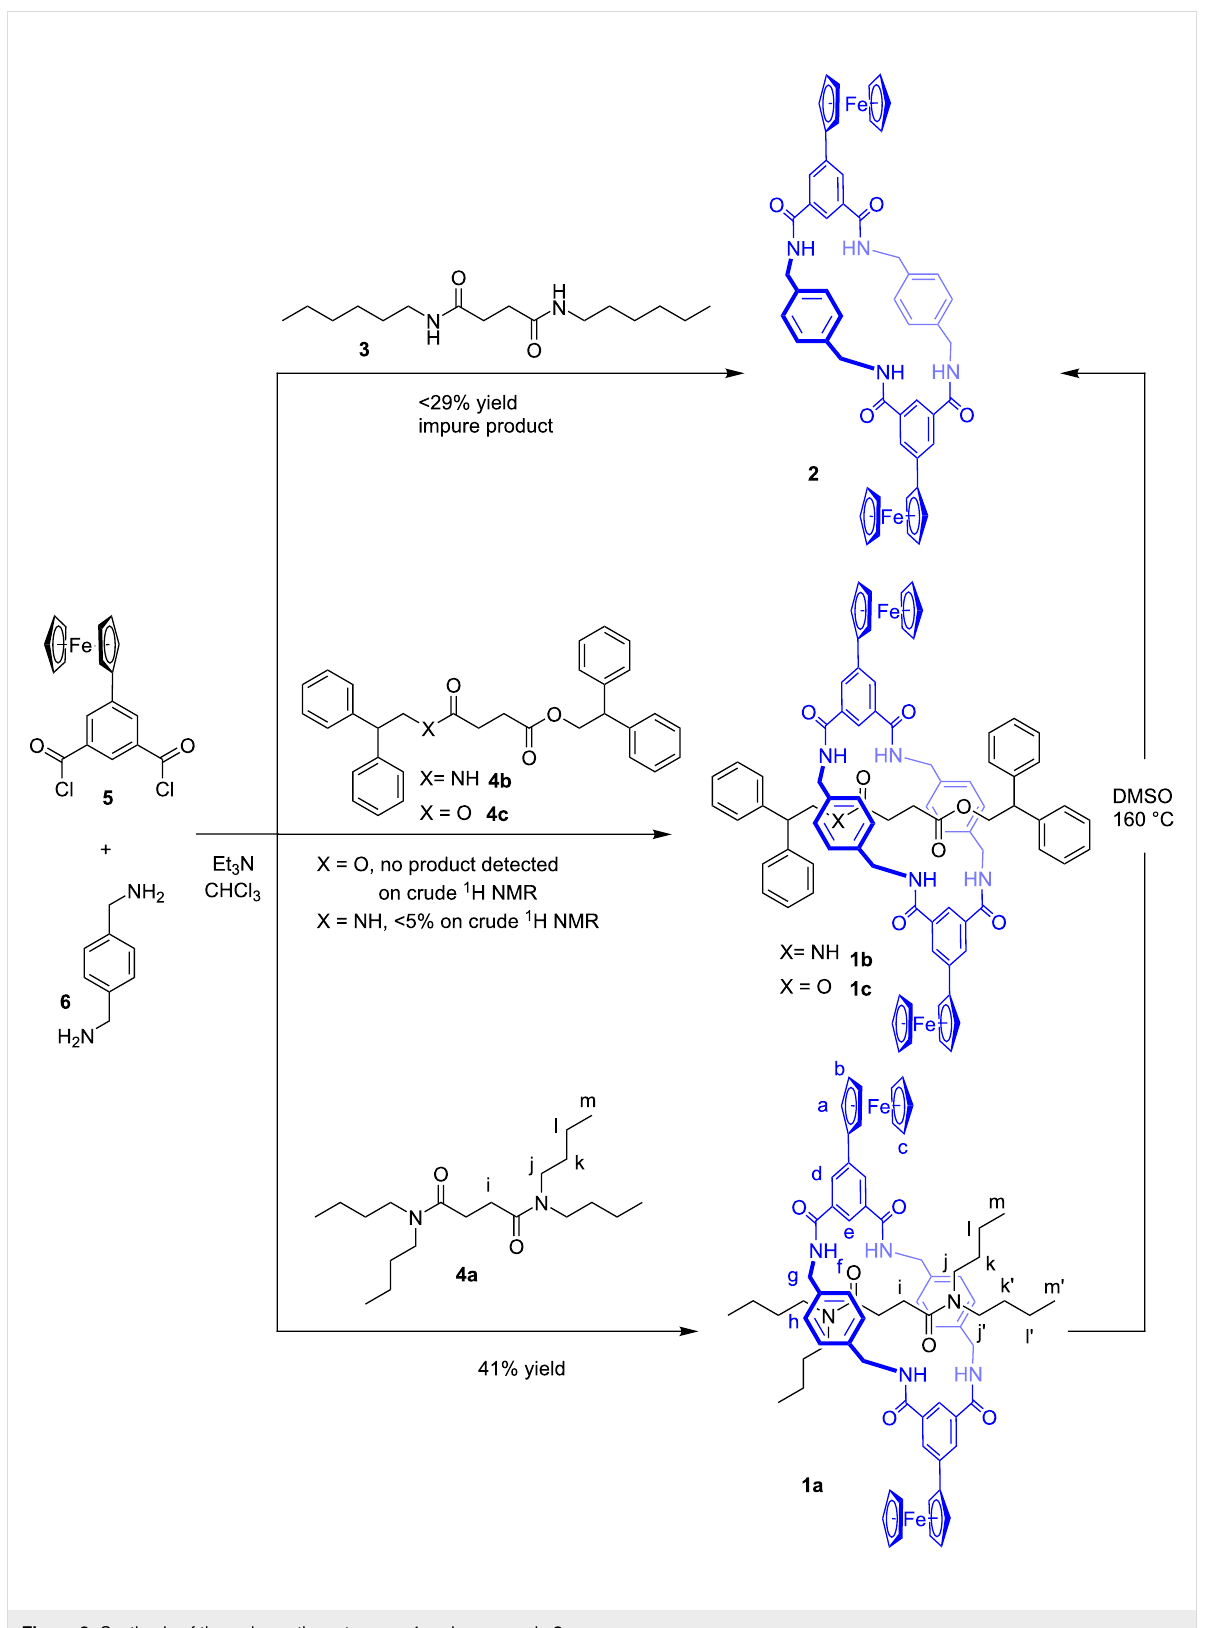
Figure 2: Synthesis of the redox-active rotaxanes 1 and macrocycle 2